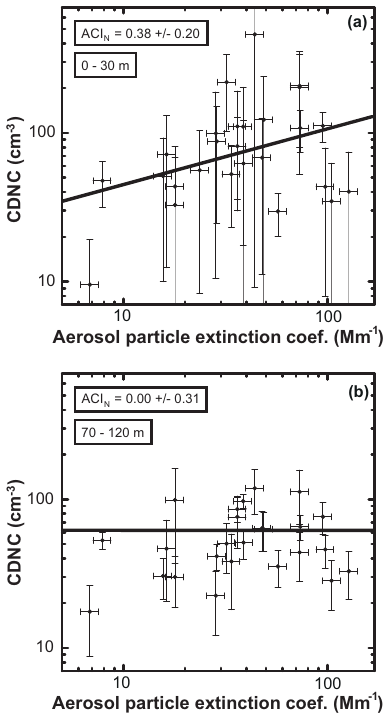
Figure 4. Same as Fig. 3 except for cloud layers from (a) cloud base to 30m above cloud base and (b) for the 70–120m layer above cloud base. The corresponding mean ACI N value and SD are given as numbers.